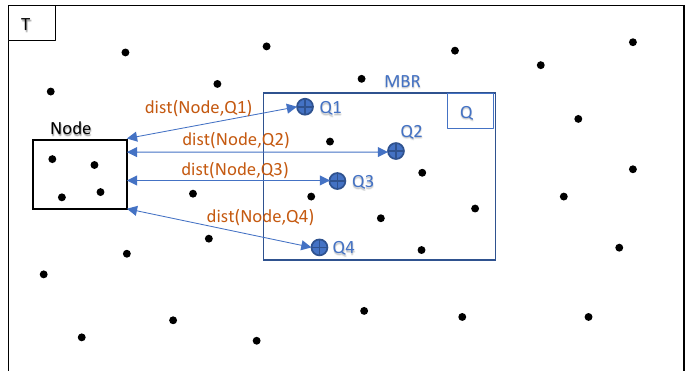
Figure 7. Heuristic 3 visualization.